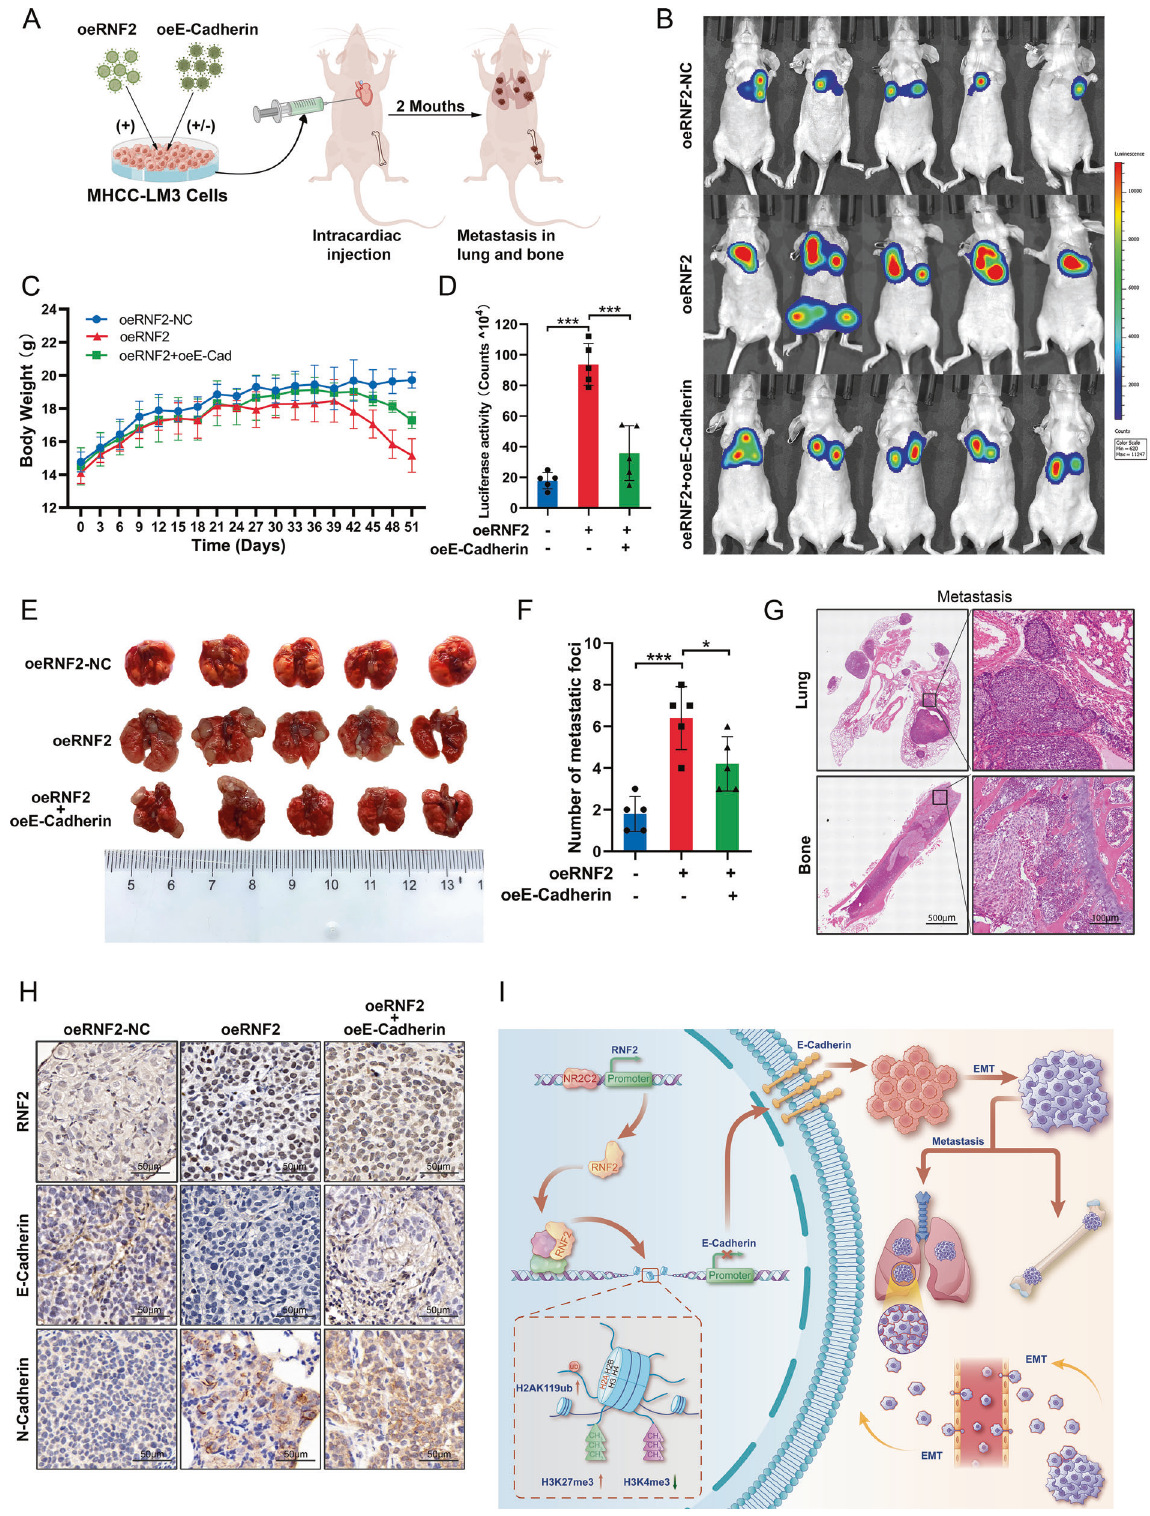
Fig. 6 RNF2 inhibits E-Cadherin expression to promote HCC cell metastasis in vivo. A Schematic illustration of metastatic tumor model constructed in nude mice by intracardiac injection. B IVIS imaging system analyzes the fl uorescence intensity in vivo. C Curves of body weight changes over time in nude mice after intracardiac injection of transfected cells. D Quantitative analysis of region of interests (ROI) counted by IVIS imaging system. E , F Representative images of lung metastasis in nude mice and quantitative analysis of the number of metastatic tumors. G Representative images of HE staining of mouse lung/bone metastasis gross anatomical specimens. H Representative IHC staining images of RNF2, E-Cadherin, and N-Cadherin expression levels in lung metastatic tumor tissues. I Illustration of the regulatory mechanisms of RNF2 in HCC.